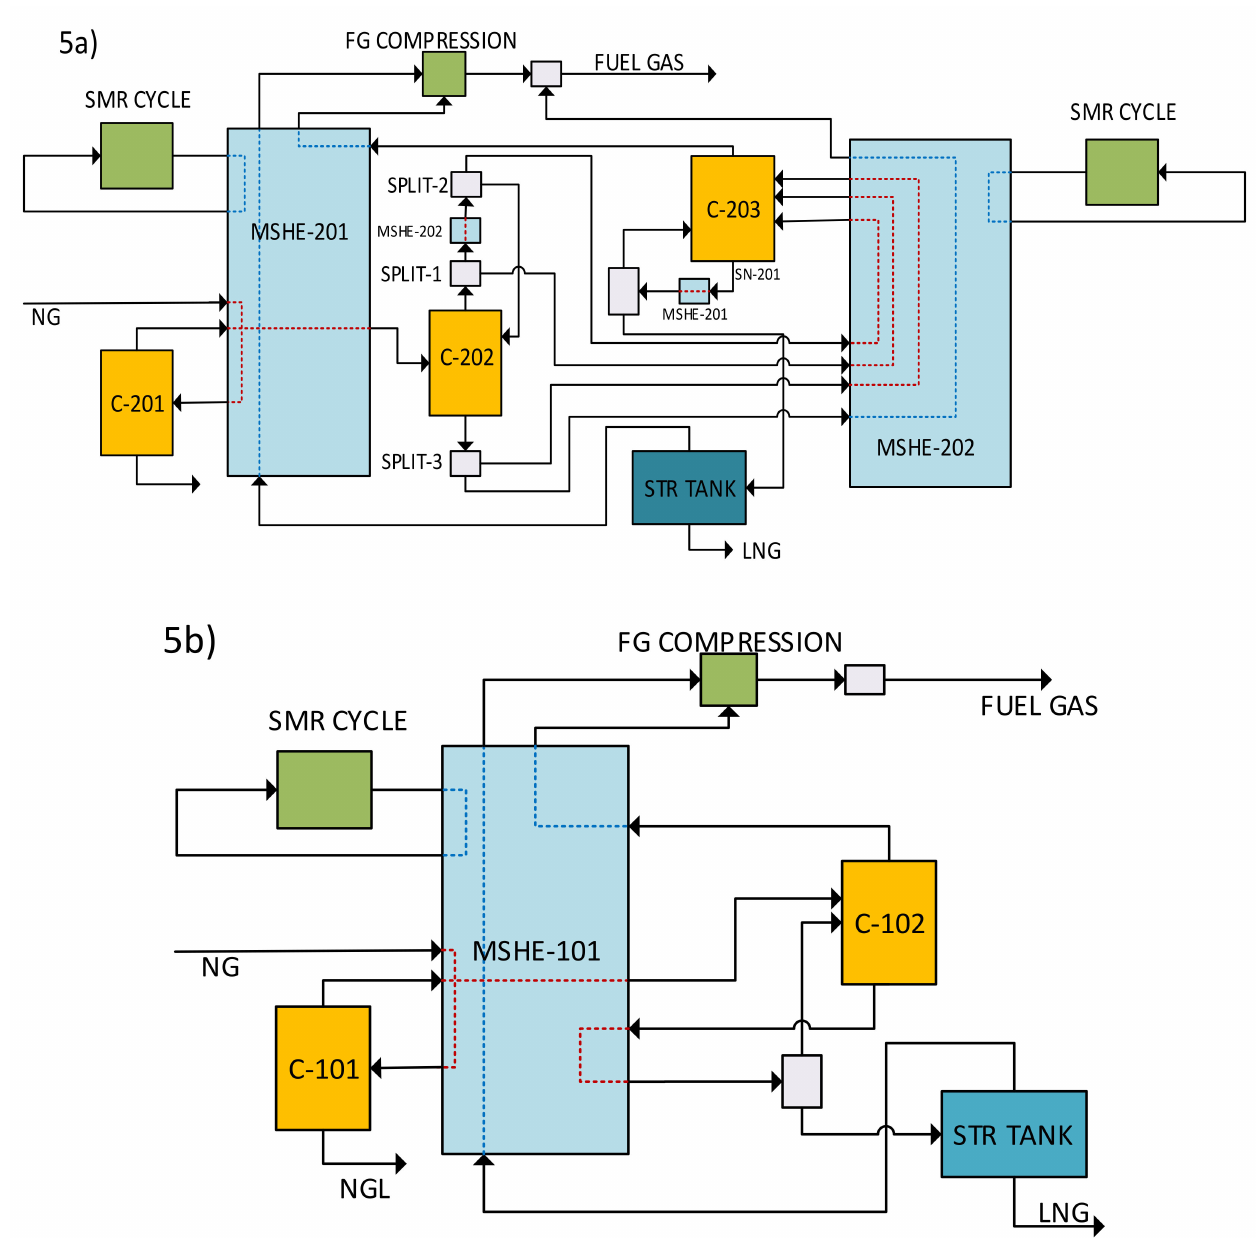
Figure 5. ( a ) Conventional process design for cold section, and ( b ) Integrated distillation process as upfront N 2